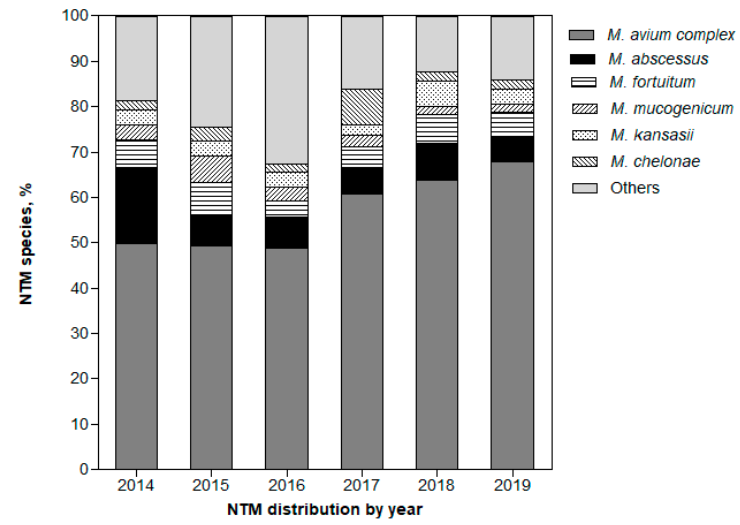
Figure 3. Trends in distribution of nontuberculous mycobacteria species isolated from pulmonary sites from 2014 to 2019.